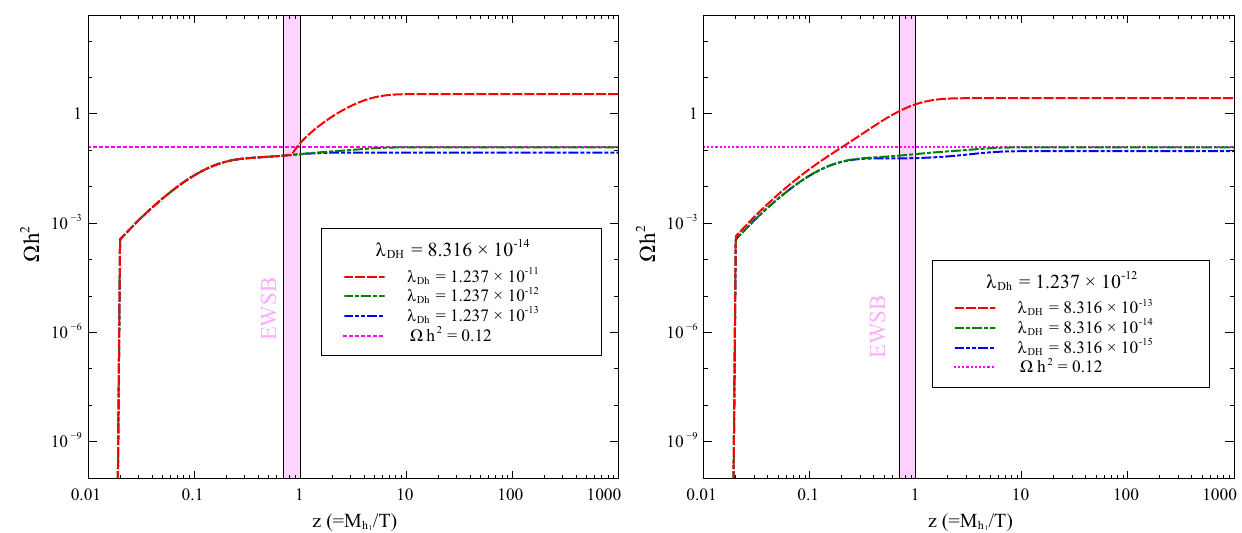
Fig. 10 Left (Right) panel: Variation of relic density (cid:9) h 2 with z for three different values of λ Dh ( λ DH ), where the other parameters are fixed at λ = 5 . 88 × 10 − 14 ( λ DH